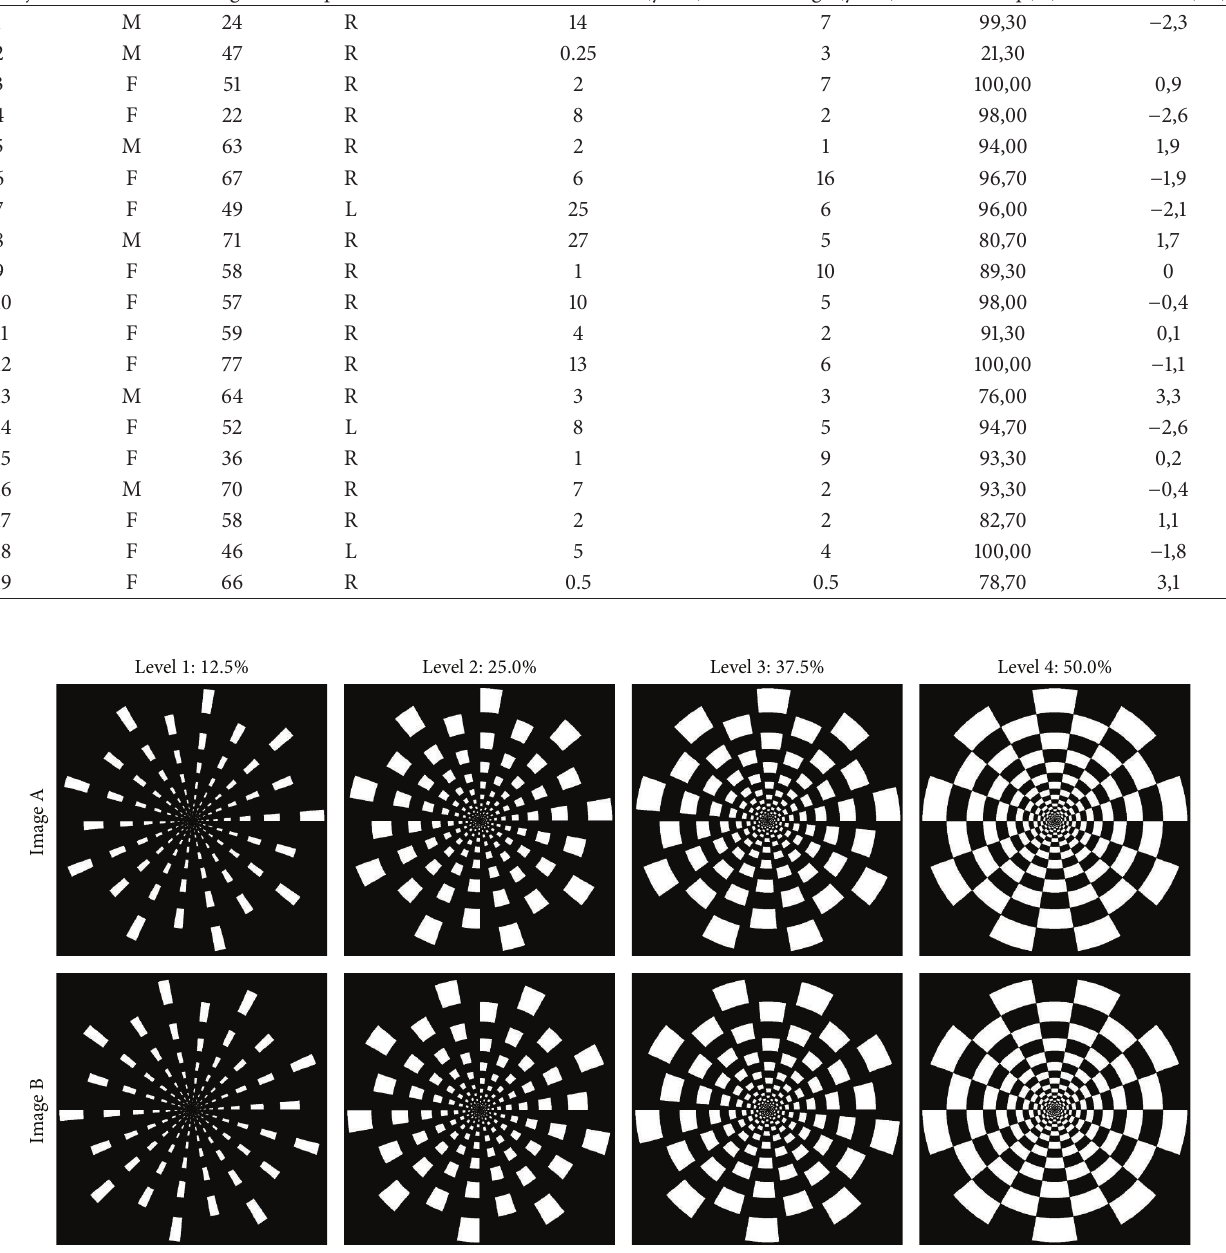
Figure 2: Flicking checkerboard pairs. The proportion of white pixels in the stimulus was 12.5, 25, 37.5, and 50% of the circular panel (from left to right). Image B is generated by rotating Image A by